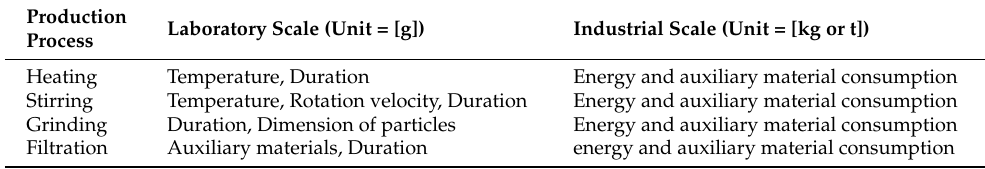
Table 2. Differences in primary data available between laboratory and industrial scales. For each production process, specific data are needed as input to build the LCA model. On the laboratory scale, data on production processes are, for instance, temperature, duration of the process, pH, etc. However, those inputs are not directly usable in an LCA study. On the industrial level, the available data are directly usable in an LCA, such as energy and auxiliary material consumption.